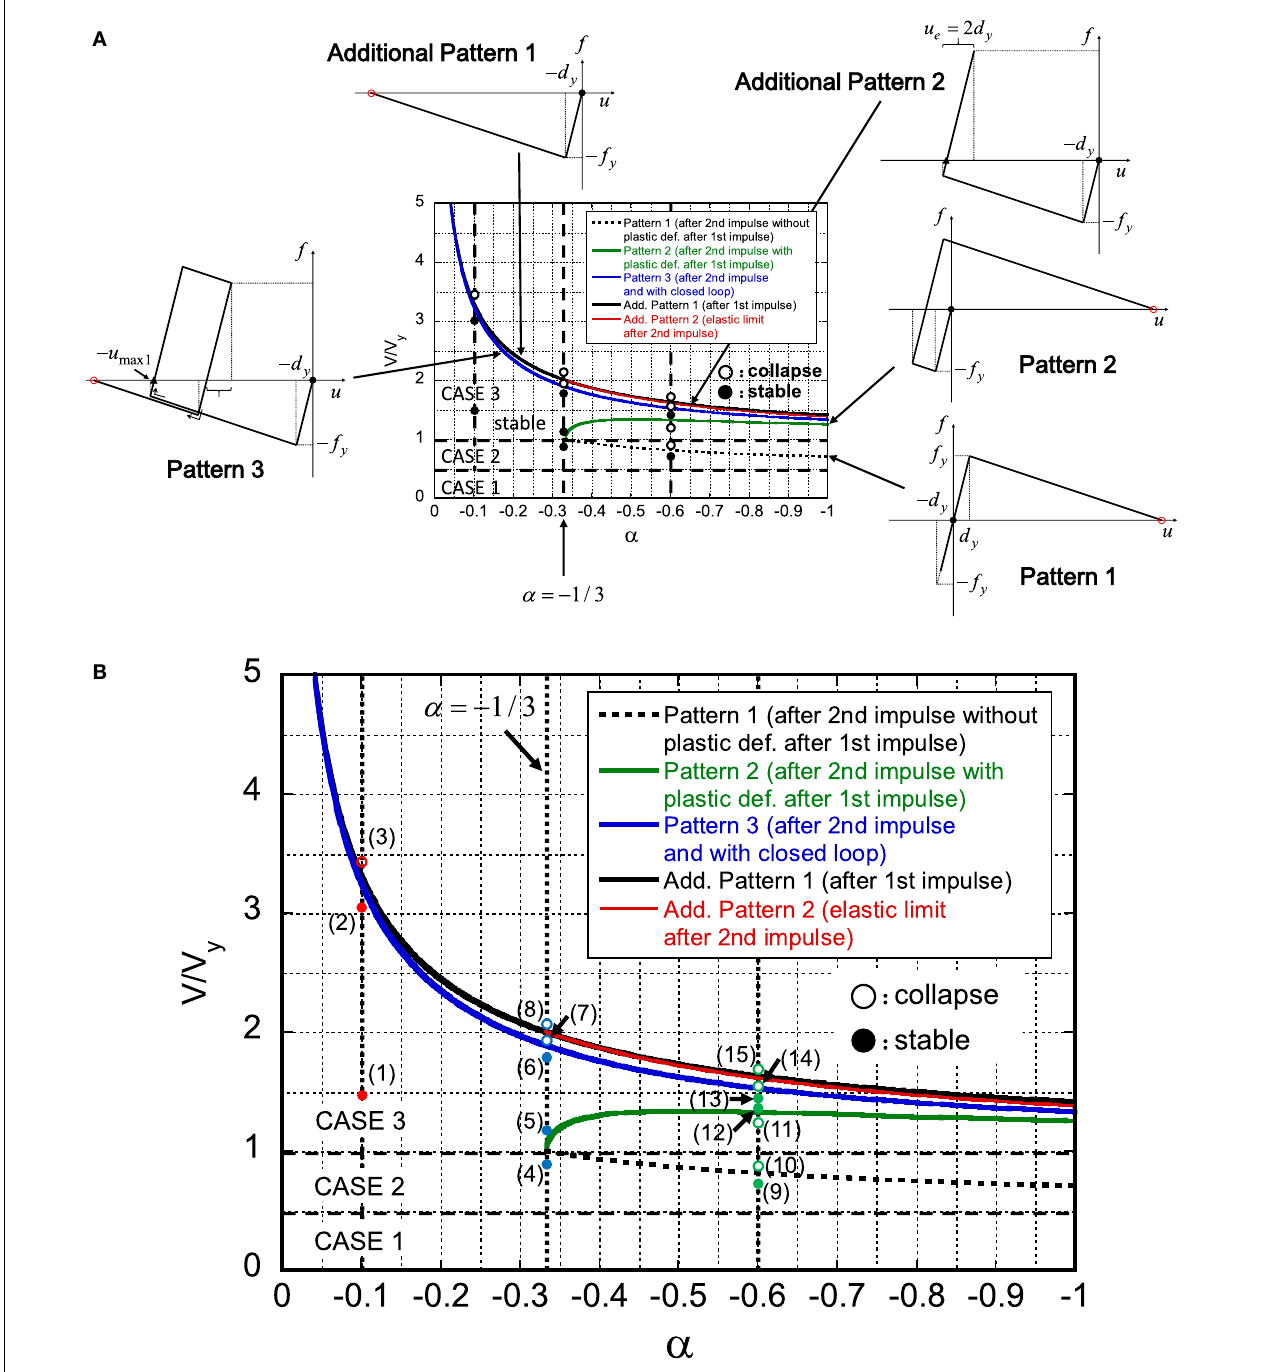
FIGURE 11 | Several patterns of stability limit (patterns of collapse): (A) stability patterns and (B) 15 points to be checked for stability .